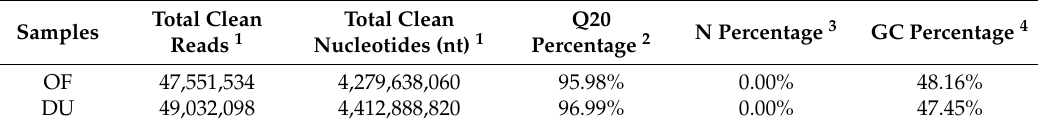
Table 1. Output statistics of sequencing.